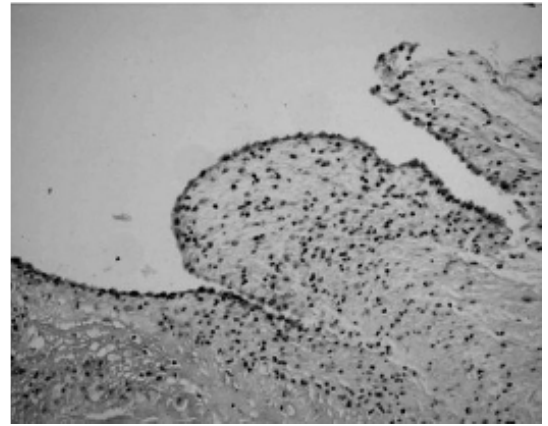
Fig. 6 – Coloração imuno-histoquímica da válvula não-aldeídica (L-Hydro). Expressão da viabilidade endotelial pelo fator VIII policlonal (magnificação da objetiva,